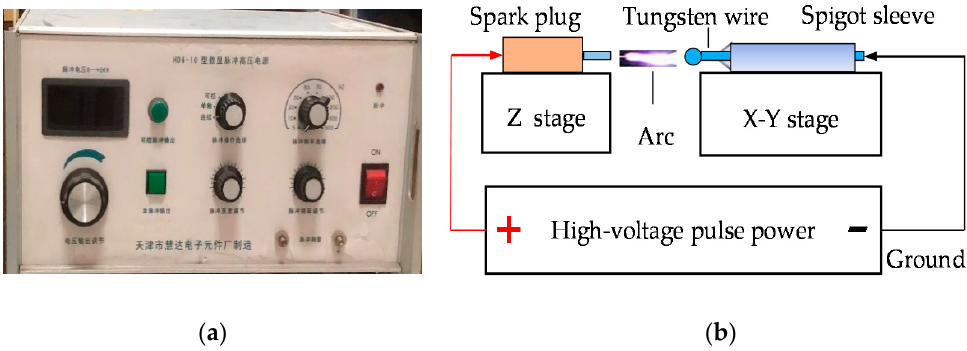
Figure 2. Diagram of the experimental device. ( a ) Experimental device and ( b ) high-voltage pulse power.